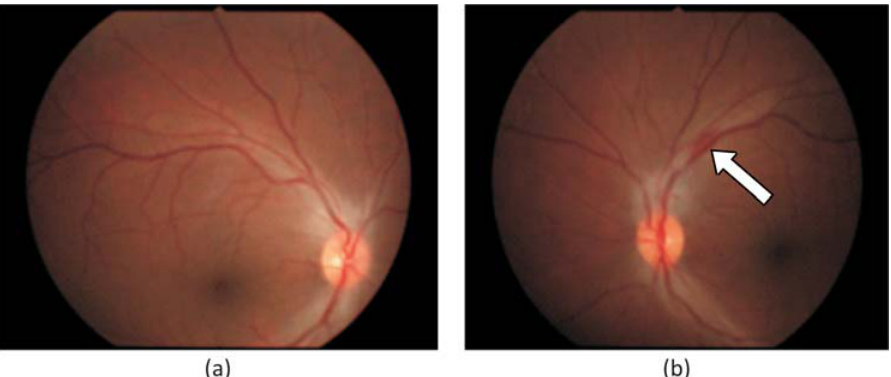
Figure 1. Fundus photograph (OD) that there was hyperemia and edema of the optic disc which taken at first visit (October 7 th , 2009): (a) (b) retinal hemorrhage at superior optic disc